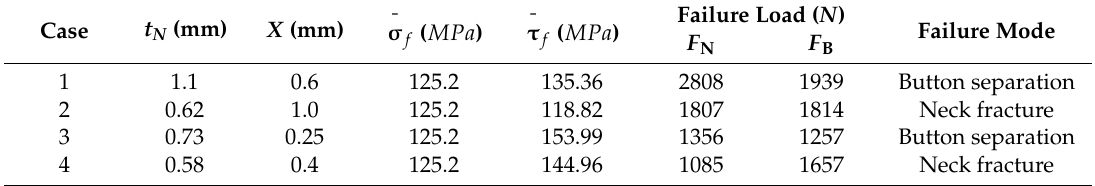
Table 3. Prediction of failure load and mode for experimental hole-clinching condition.